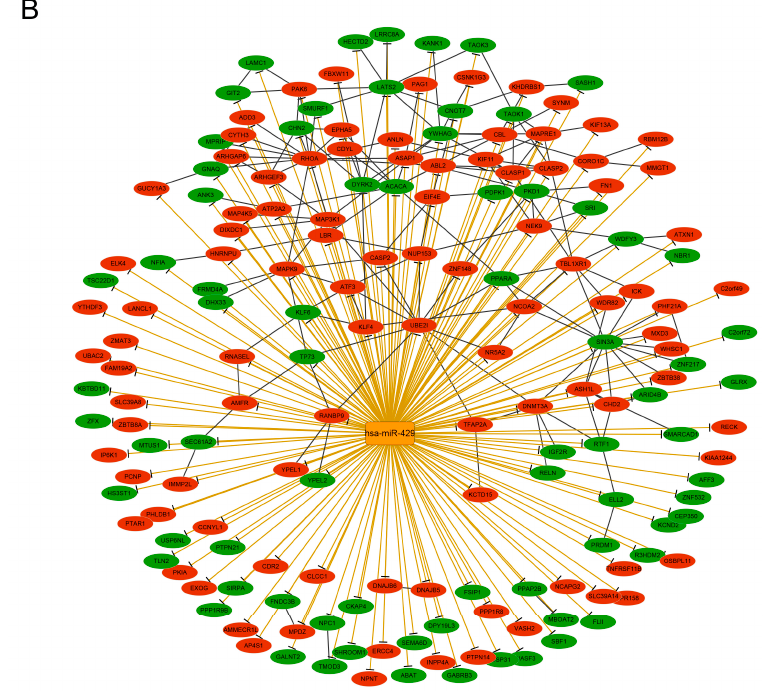
Figure 2. TF target and miRNA–target regulatory networks. ( A ) TF-target network. Red diamond: up-regulated TF; green diamond: down-regulated TF; grey diamond: TF that is not differentially expressed between LNCaP-AI-F and LNCaP cells; red circle: up-regulated PMDEG; green circle: down-regulated PMDEG; red line with arrow: a TF targets a PMDEG and the TF-binding motif overlaps with a hypermethylated DMR; green line: a TF targets a PMDEG and the TF-binding motif overlaps with a hypomethylated DMR; dotted line: the confirmed regulatory relationships by data validation using the GSE41701 dataset; ( B ) bmiRNA–target network. Yellow rectangle: down-regulated MDEmiRNA; red circle: up-regulated MDEG; green circle: down-regulated MDEG; yellow line with T-shape: a MDEmiRNA targets a MDEG; grey line: protein-protein interaction between two MDEGs. TF: transcription factor; miRNA: microRNA; PMDEG: differentially expressed gene whose promoter overlapped with DMR(s); MDEmiRNA: differentially expressed microRNA that overlapped with DMR(s); MDEG: differentially expressed gene that overlapped with DMR(s); DMR: differentially methylated region.